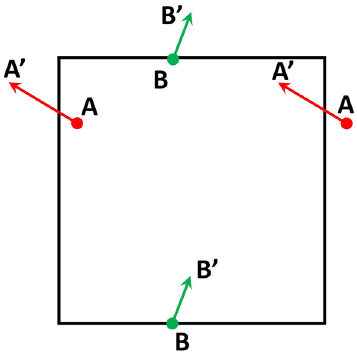
Figure 2. Schematic illustration of the periodic boundary